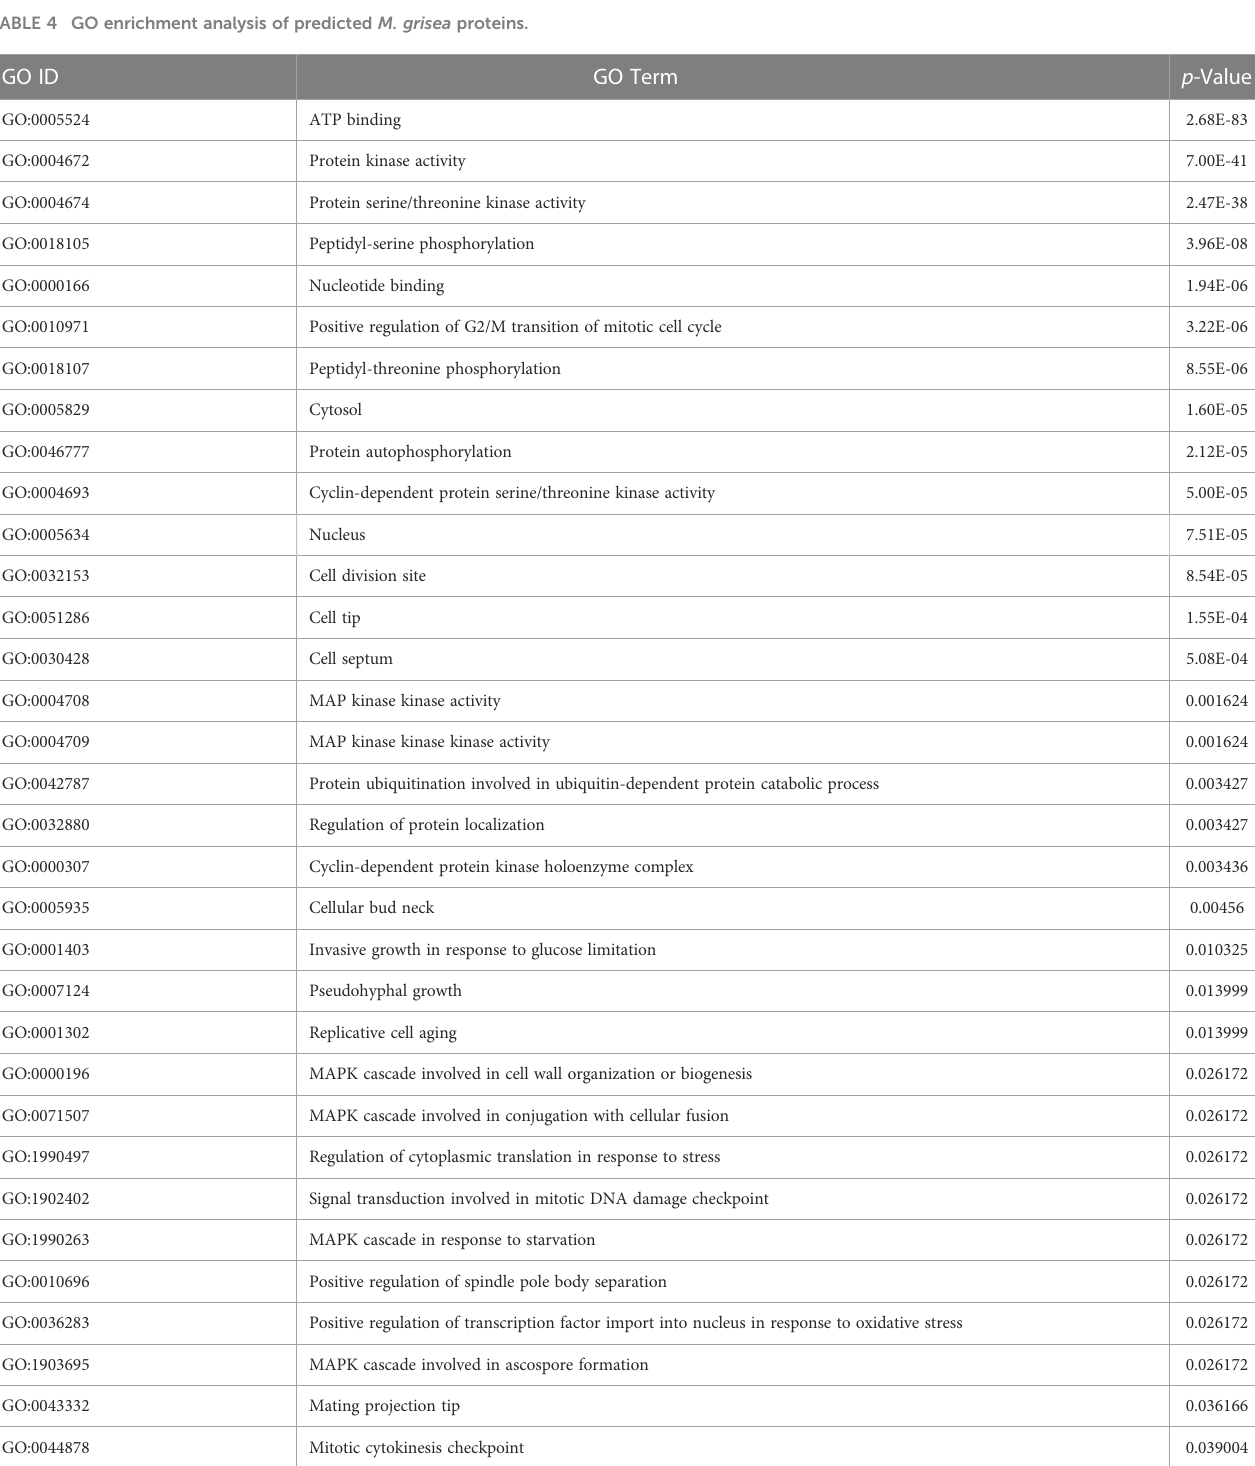
TABLE 4 GO enrichment analysis of predicted M. grisea